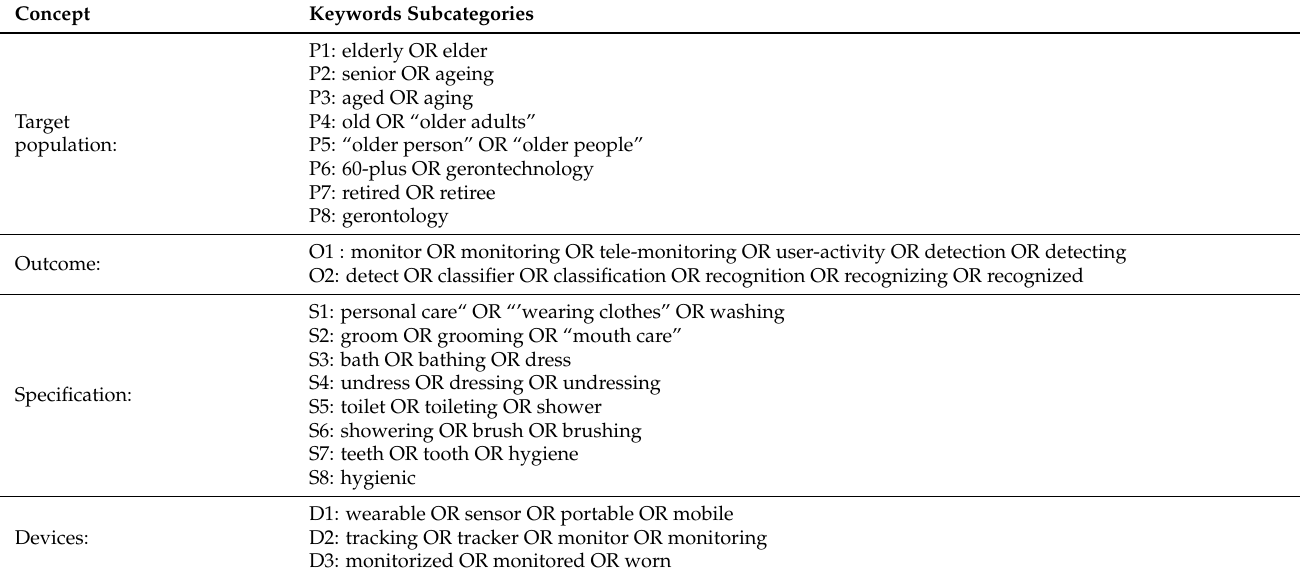
Table A2. Subcategories of Keywords applied in Science Direct.